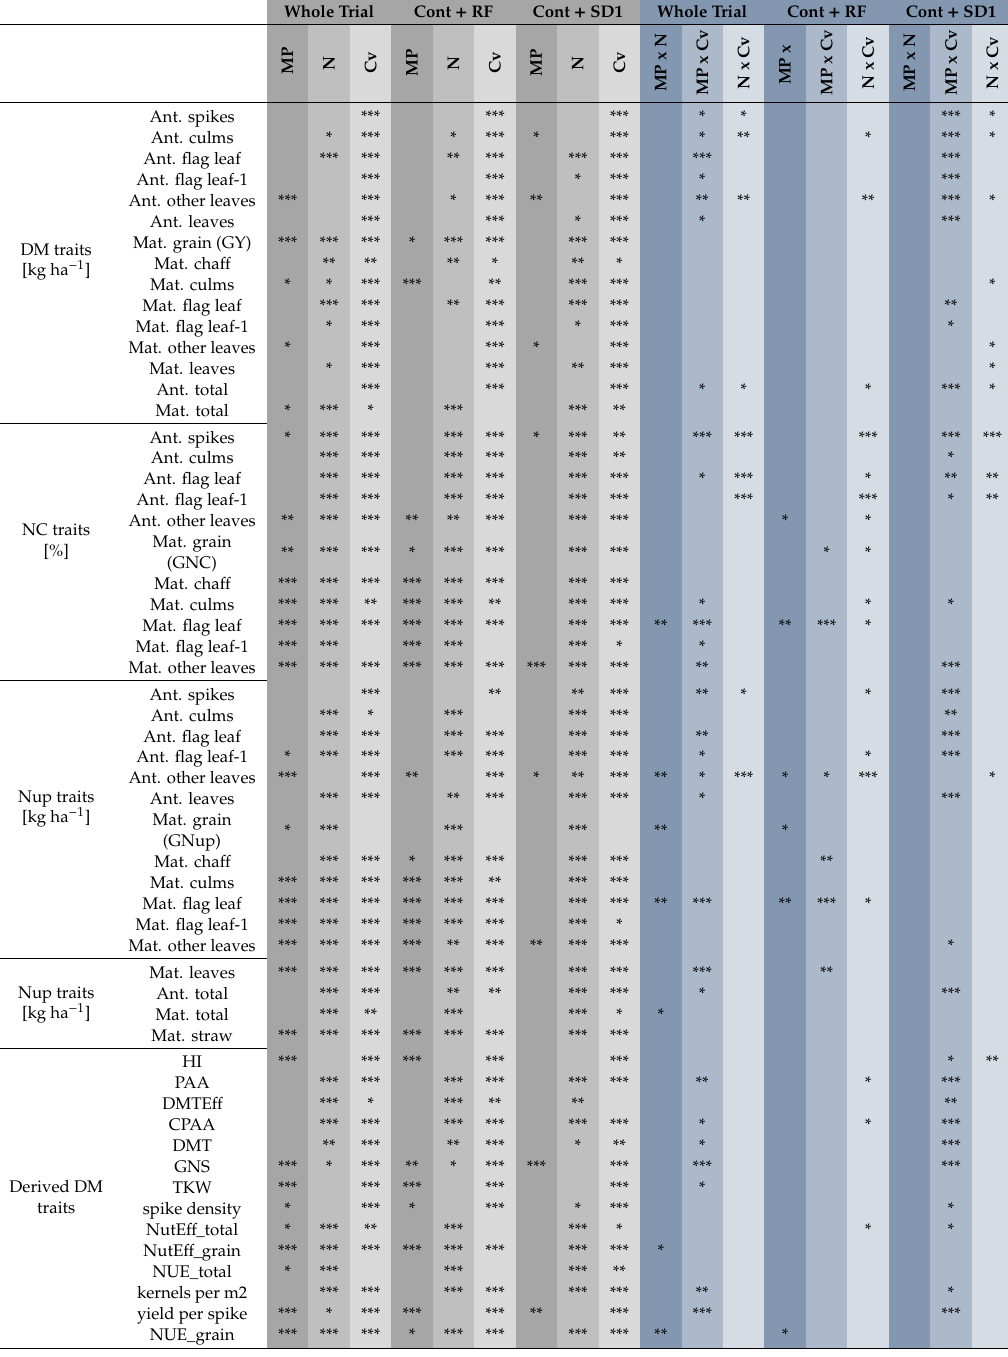
Table 4. ANOVA results for significant (*: p < 0.05, **: p < 0.01, **: p < 0.001) e ff ects of the main plot (MP), N level (N) and cultivar (Cv) as well as two-way interactions, SD1: Sowing date 1, Cont: Control, RF: Reduced fungicide. Models are reported for the whole trial and for the combined main plots Cont + RF and Con t + SD1 for assessing the e ff ect of reduced fungicide and SD1 in comparison to Cont, respectively. The main e ff ects are shaded in gray and interaction e ff ects in blue. For anthesis date, no cultivar e ff ects are reported due to missing data. ‘Other leaves’ denotes the leaves, excluding both uppermost leaf layers, ‘Ant.’ anthesis and ‘Mat.’ maturity. See Supplementary Table S1 for results of further indirect DM and N traits related to organ-specific DM and N allocation, DM and N translocation and translocation e ffi